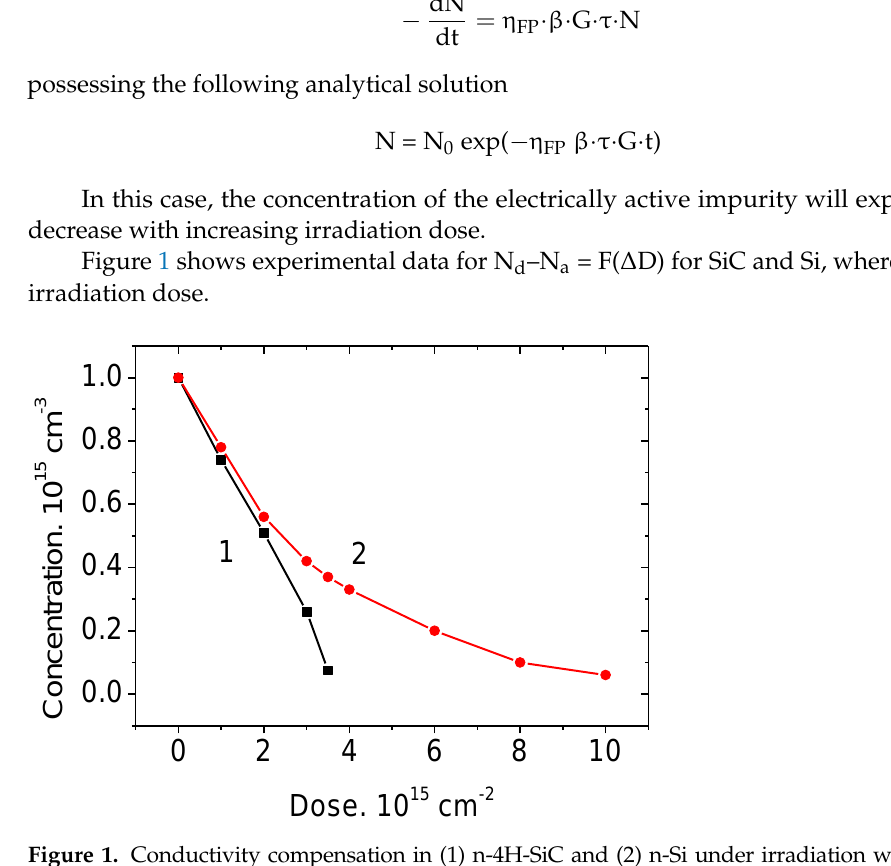
Figure 1. Conductivity compensation in (1) n-4H-SiC and (2) n-Si under irradiation with 0.9 MeV electrons. Points represent experimental data. The straight line 1 represents a calculation according to Equation (9) at a parameter η FP of 0.25 cm −1 . Curve 2 represents a calculation by Equation (14) at a factor ( η FP β τ ) in the exponent equal to 1.2 × 10 − 16 cm 2